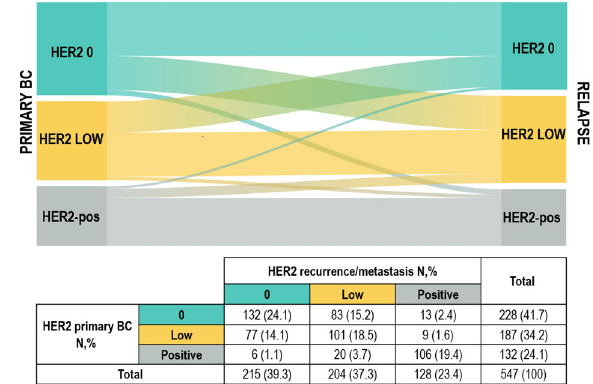
Fig. 2 HER2 expression evolution from primary BC to relapse. Figure 2 shows the evolution of HER2 expression from primary to recurrent breast cancer. Absolute numbers and percentages are reported. BC breast cancer, N